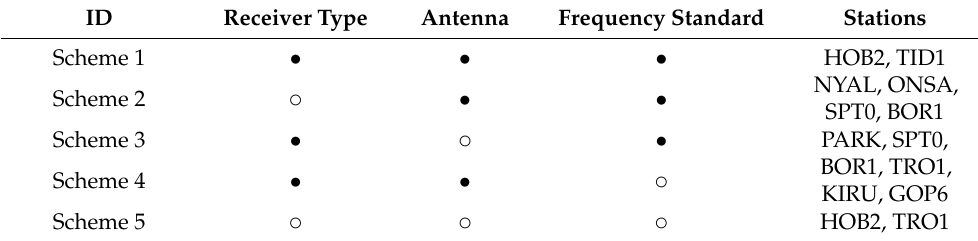
Table 3. Comparative schemes and corresponding stations.